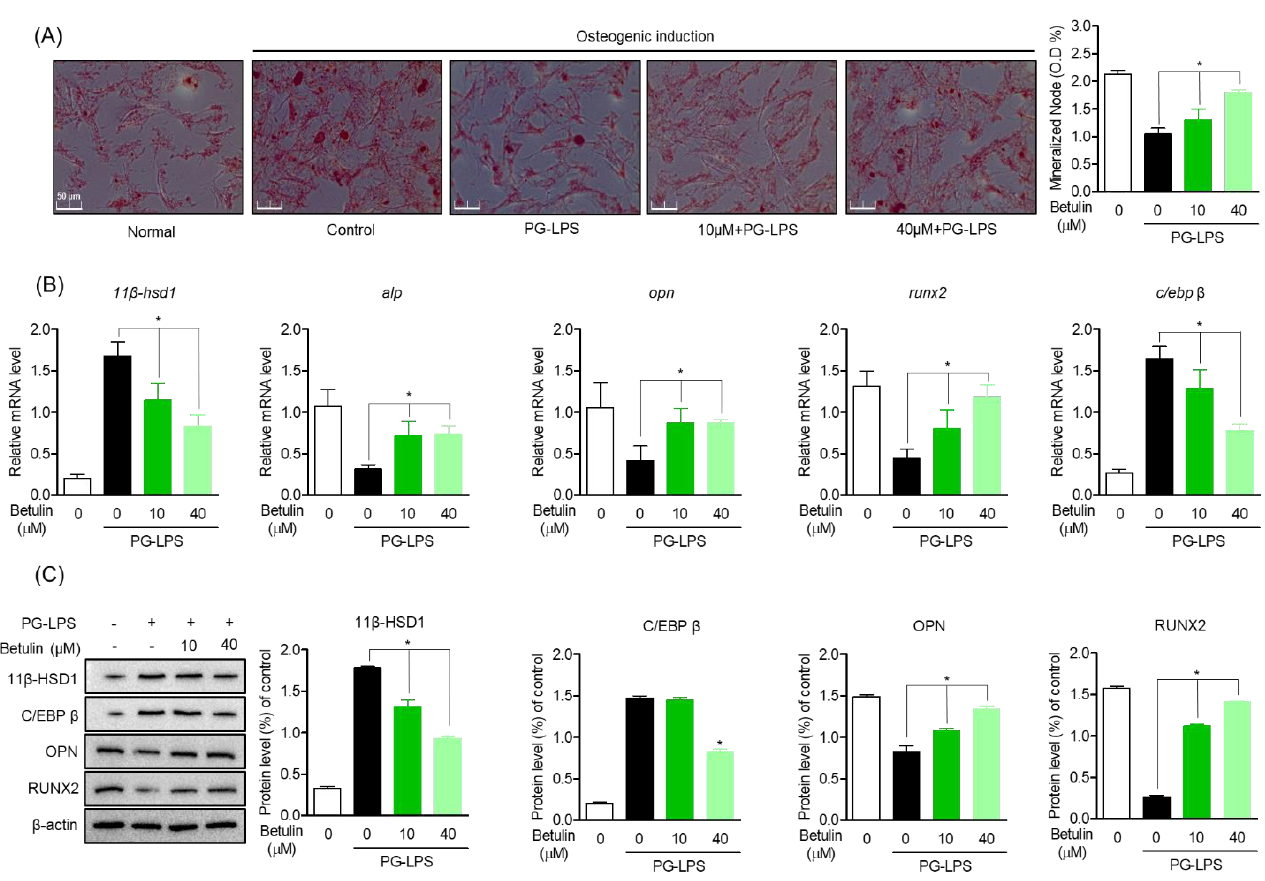
Figure 5. Inhibitory Effect of Betulin on Inflammatory Mediators by Regulating 11 β -HSD1 and C/EBP Activities. The HPDL cells (5 × 10 3 cells/mL) were pretreated with or without the indicated concentration of betulin, after treatment with PG-LPS, it was cultured for 14 days. The result of mineralization was measured by alizarin red s (ARS) staining ( A ). The level of osteogenic induction specific genes ( alp, opn, runx2 ) and proteins were analyzed by real-time PCR ( B ) and Western blot ( C ). The results were normalized to gapdh and β -actin expression. * p < 0.05 was considered significant differences between only PG-LPS treated groups.